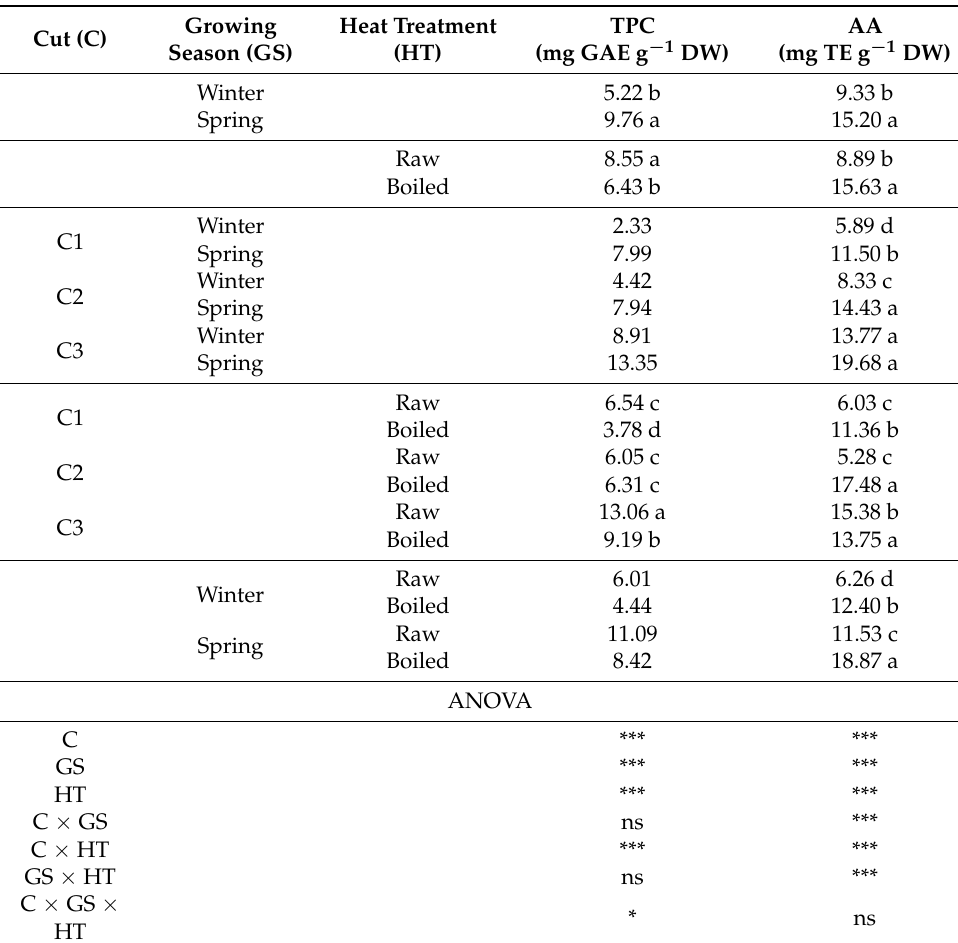
Table 3. Cont. Cut